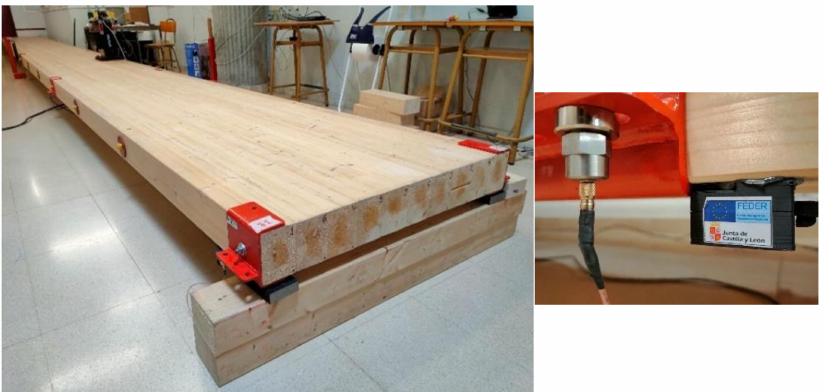
Figure 5. Picture of the structure under test ( left ) and pair of collocated sensors ( right ).